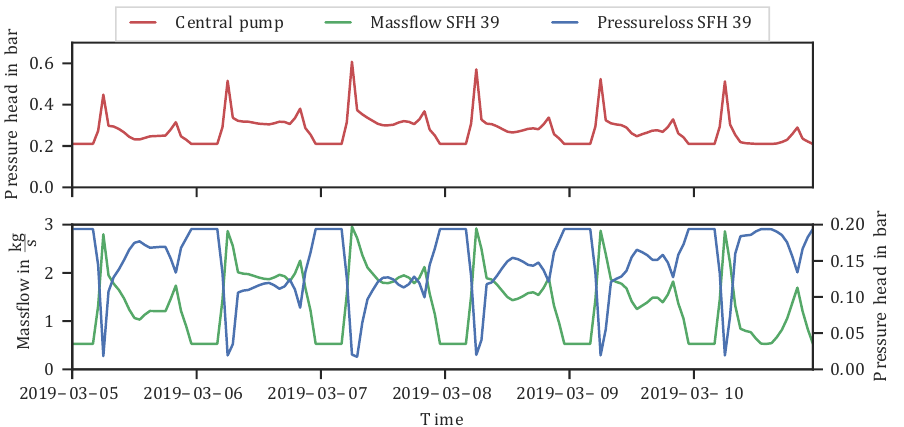
Figure 10. Central pump case with pressure increase of the central pump, pressure loss over the substation as well as the mass flow at substation of SFH 39.